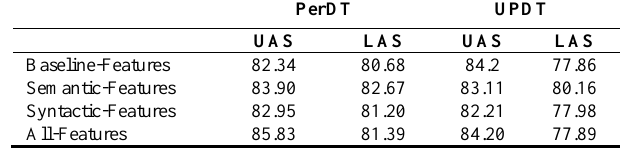
Table 4. Non-Projective-First-Order.